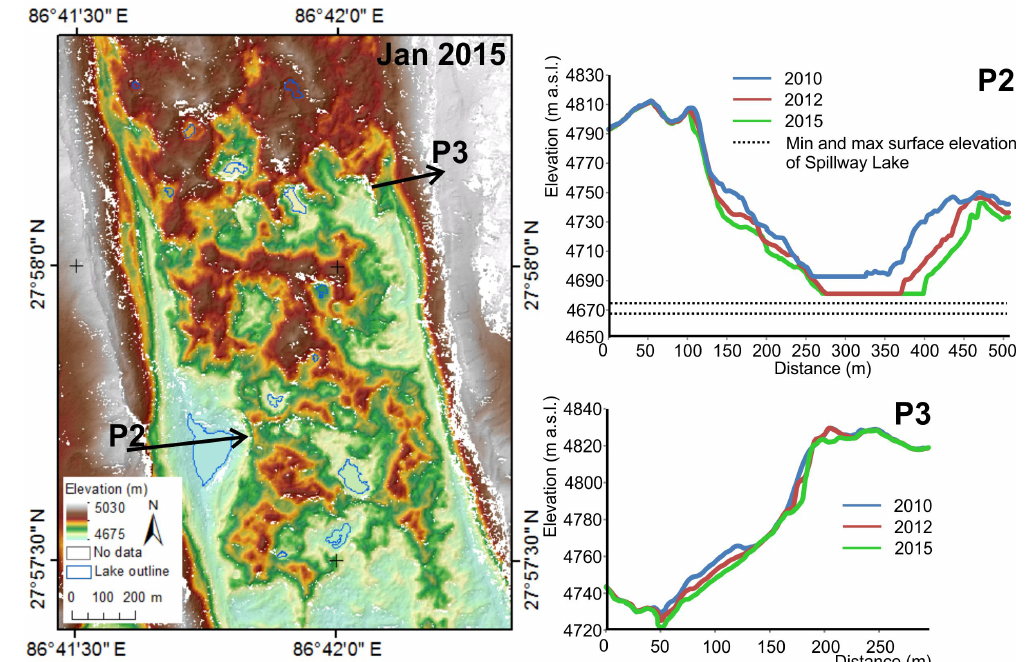
Figure 11. Extract from the 2015 DEM and selected cross profiles in 2010, 2012, and 2015, showing lateral troughs, subsidence of trough floors, and erosion of moraine